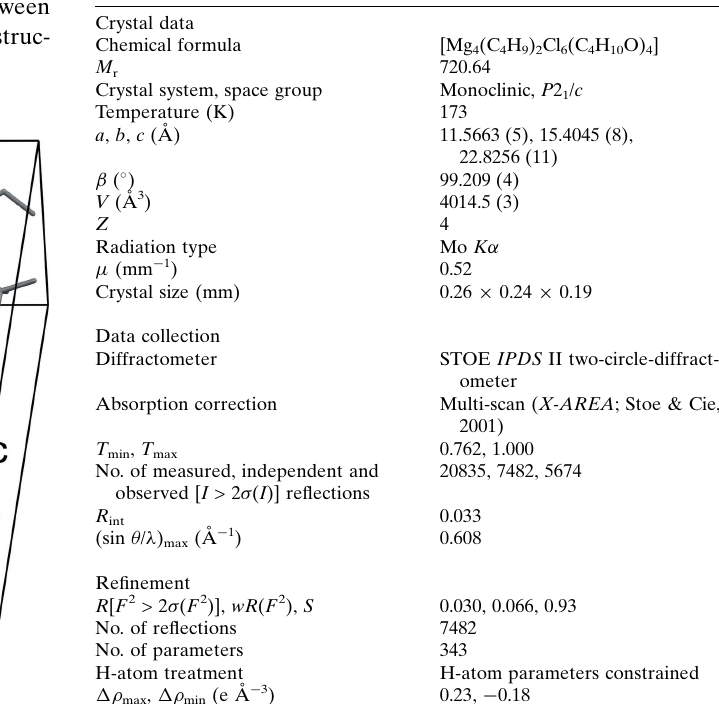
Table 3 Experimental